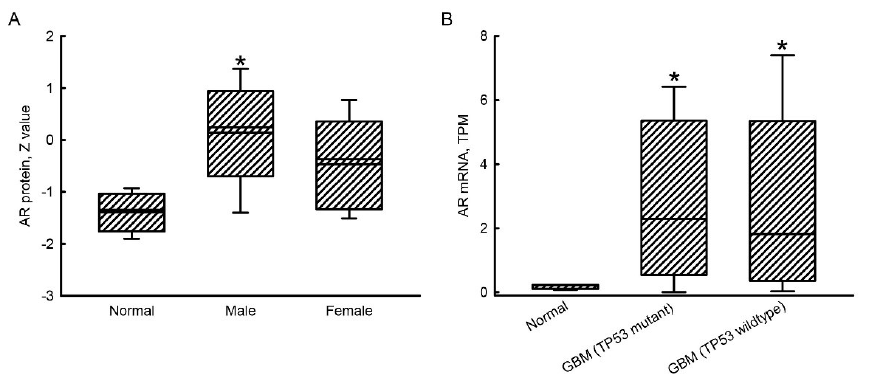
Figure 1. Upragulation of androgen receptor (AR) mRNA and protein expressions in human glio- blastoma multiforme (GBM) patients. Levels of the AR protein in normal human brains ( n = 10) and human male ( n = 55) and female ( n = 44) GBM tissues were mined from The Cancer Genome Atlas (TCGA) database and analyzed using the UALCAN platform (http://ualcan.path.uab.edu/, accessed on 12 July 2022) ( A ). Corelations of AR mRNA expression in human GBM tissues with wild-type and mutant tumor protein 53 (TP53) were carried out in the UALCAN system ( B ). Each value rep- resents the minimum, lower quartile, median, upper quartile, and maximum. An asterisk (*) indi- cates that the value significantly differs from the respective normal group, at p < 0.05. TPM, tran- scripts per million.